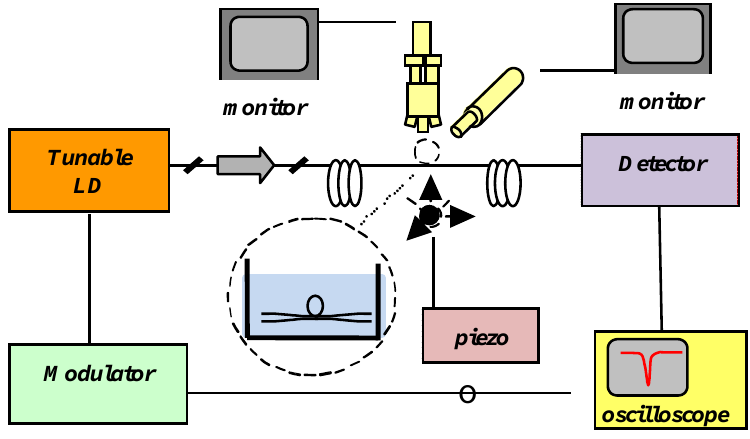
Figure 6. A schematic diagram of the experimental arrangement employing a bi-conical tapered fiber